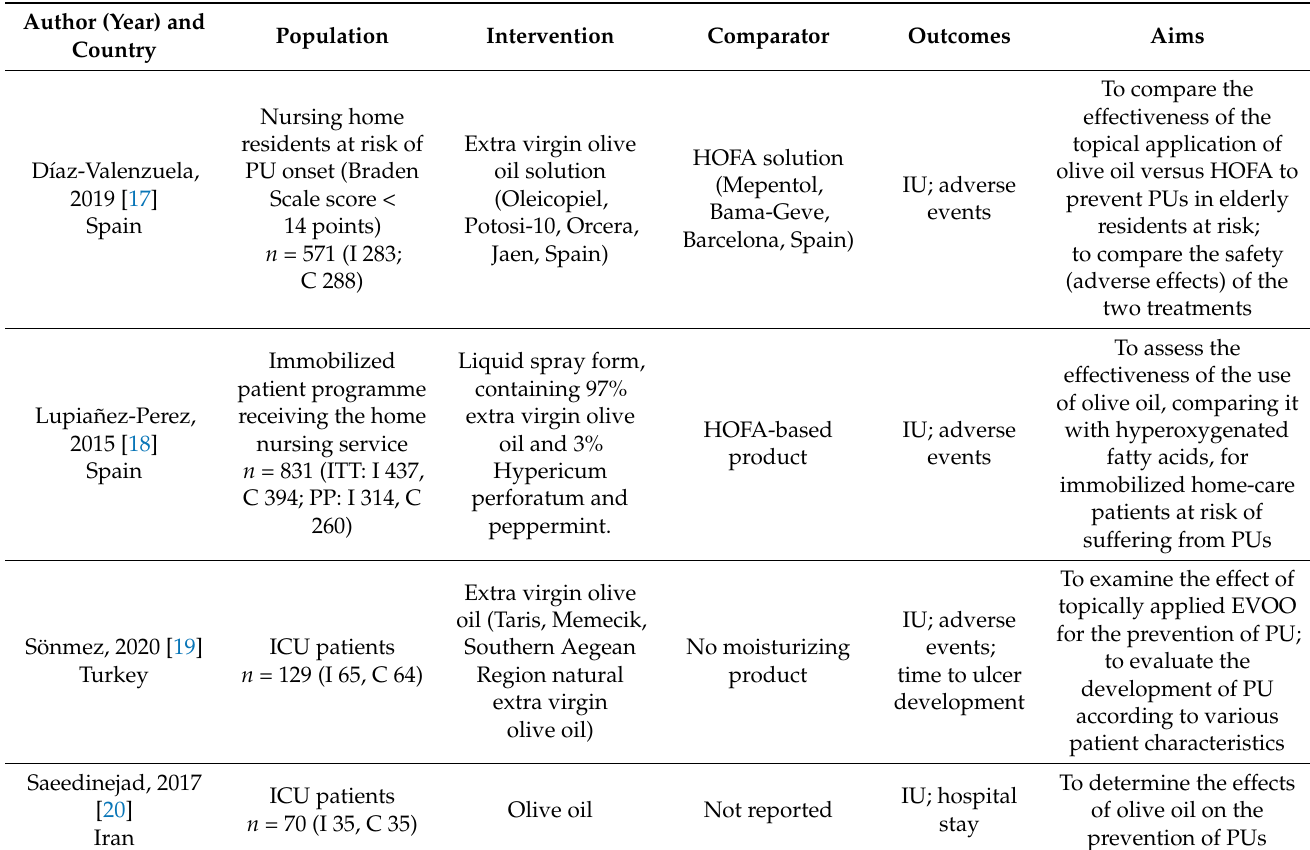
Table 1. Characteristics of included studies, RCTs, studying olive oil for preventing pressure ulcers ( n =